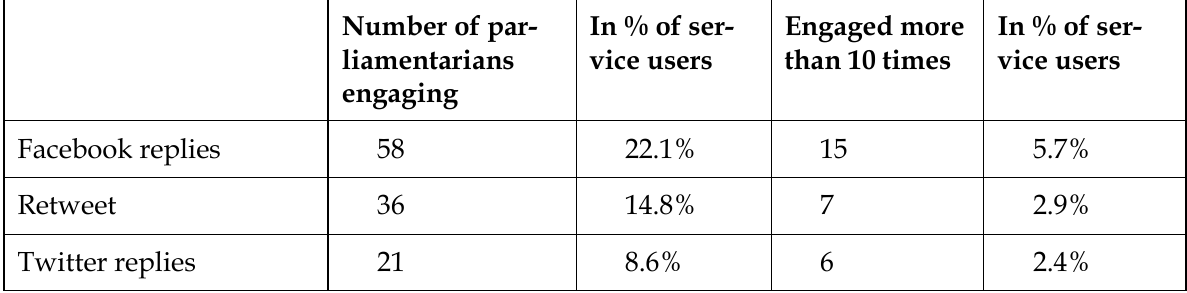
Table 4: Engagement with commentators on Facebook and Twitter, in one week, February 2016 (source: